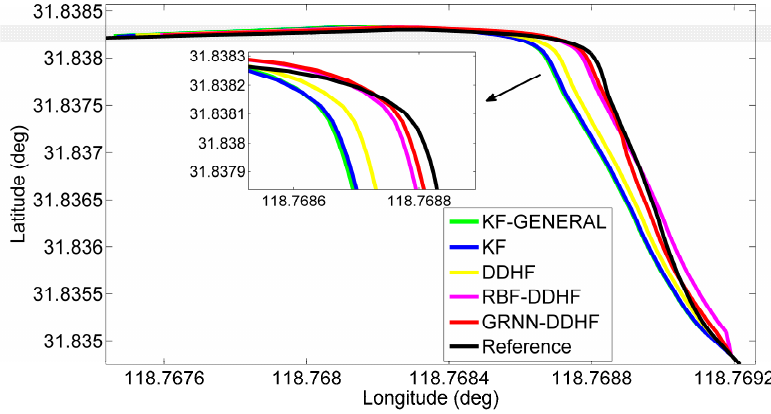
Figure 8. Positioning results during GPS outage 1 in trajectory 1.